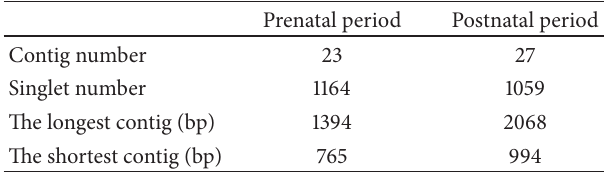
Table 2: The analysis of prenatal and postnatal contigs by CAP3. Prenatal